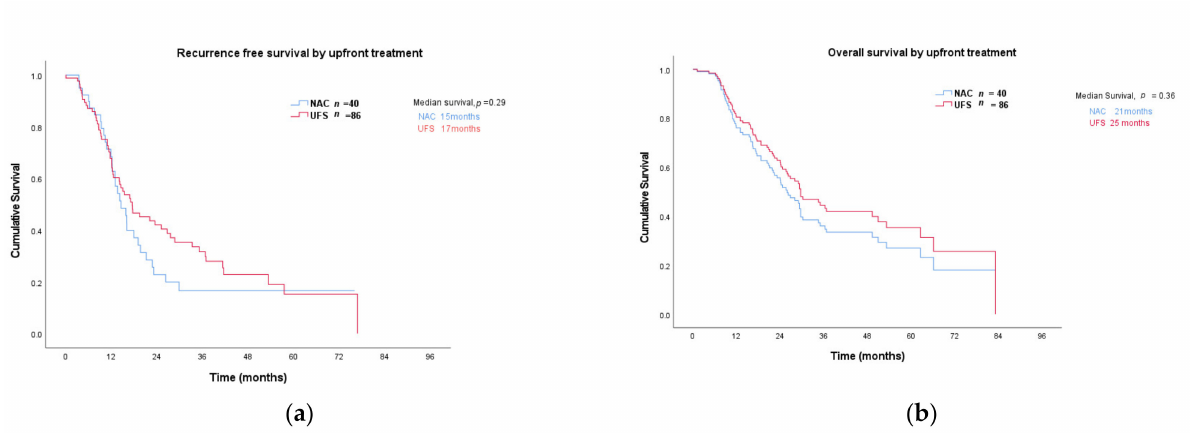
Figure 2. ( a ) Recurrence free; ( b ) overall survival: NAC—neoadjuvant chemotherapy; UFS—upfront